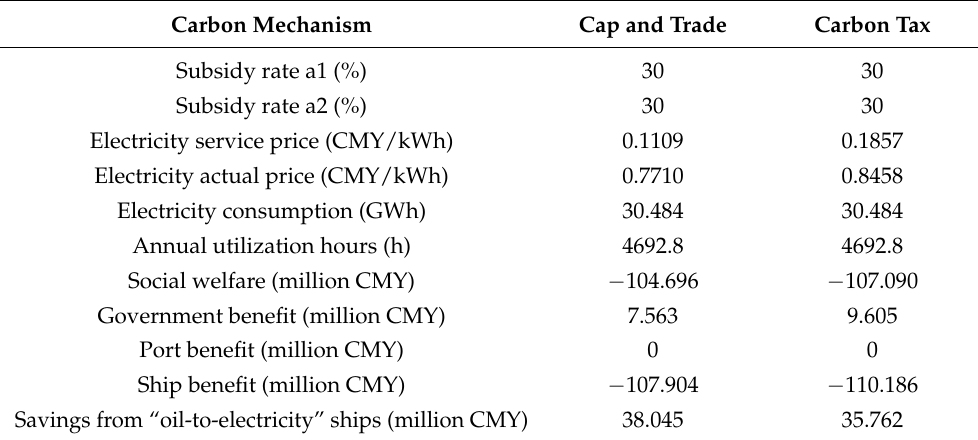
Table 4. Comparison of the impact of carbon price on economic benefits to all parties under the two carbon regimes.